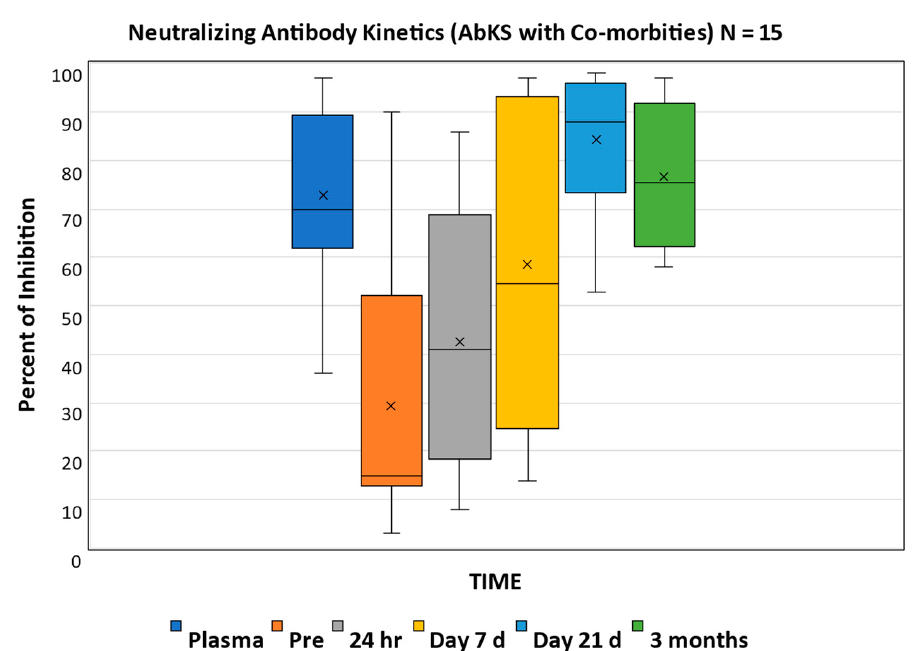
Figure 3. Percentage of inhibition over time in hosts with co-morbidities shows a substantial increase in median value at 24 h post-infusion (15% to 41%); the change from 24 h to 7 days (41–54.5%) was modest and below the median % inhibition of CCP. Only at day 21, a substantial increment is noted compared to 24 h after CCP (41–88%). The mean is identified by “x”. The median hospital length of stay was 7.0 days (IQR: 5.5, 10.0) and the ICU length of stay (16/28 patients required ICU) was 5.0 days (IQR: 2.0, 7.5). Pre-CCP median COVID- 19 severity score was 5.0 (IQR: 5.0, 6.0), which reduced slightly to 4.5 by day 3 (IQR: 3.5, 5.0), p = 0.248, and decreased significantly to 1.0 by day 7 or at discharge (IQR: 1.0, 4.0), p < 0.001. The favorable change in severity score was similar for all age groups (Figure 4).